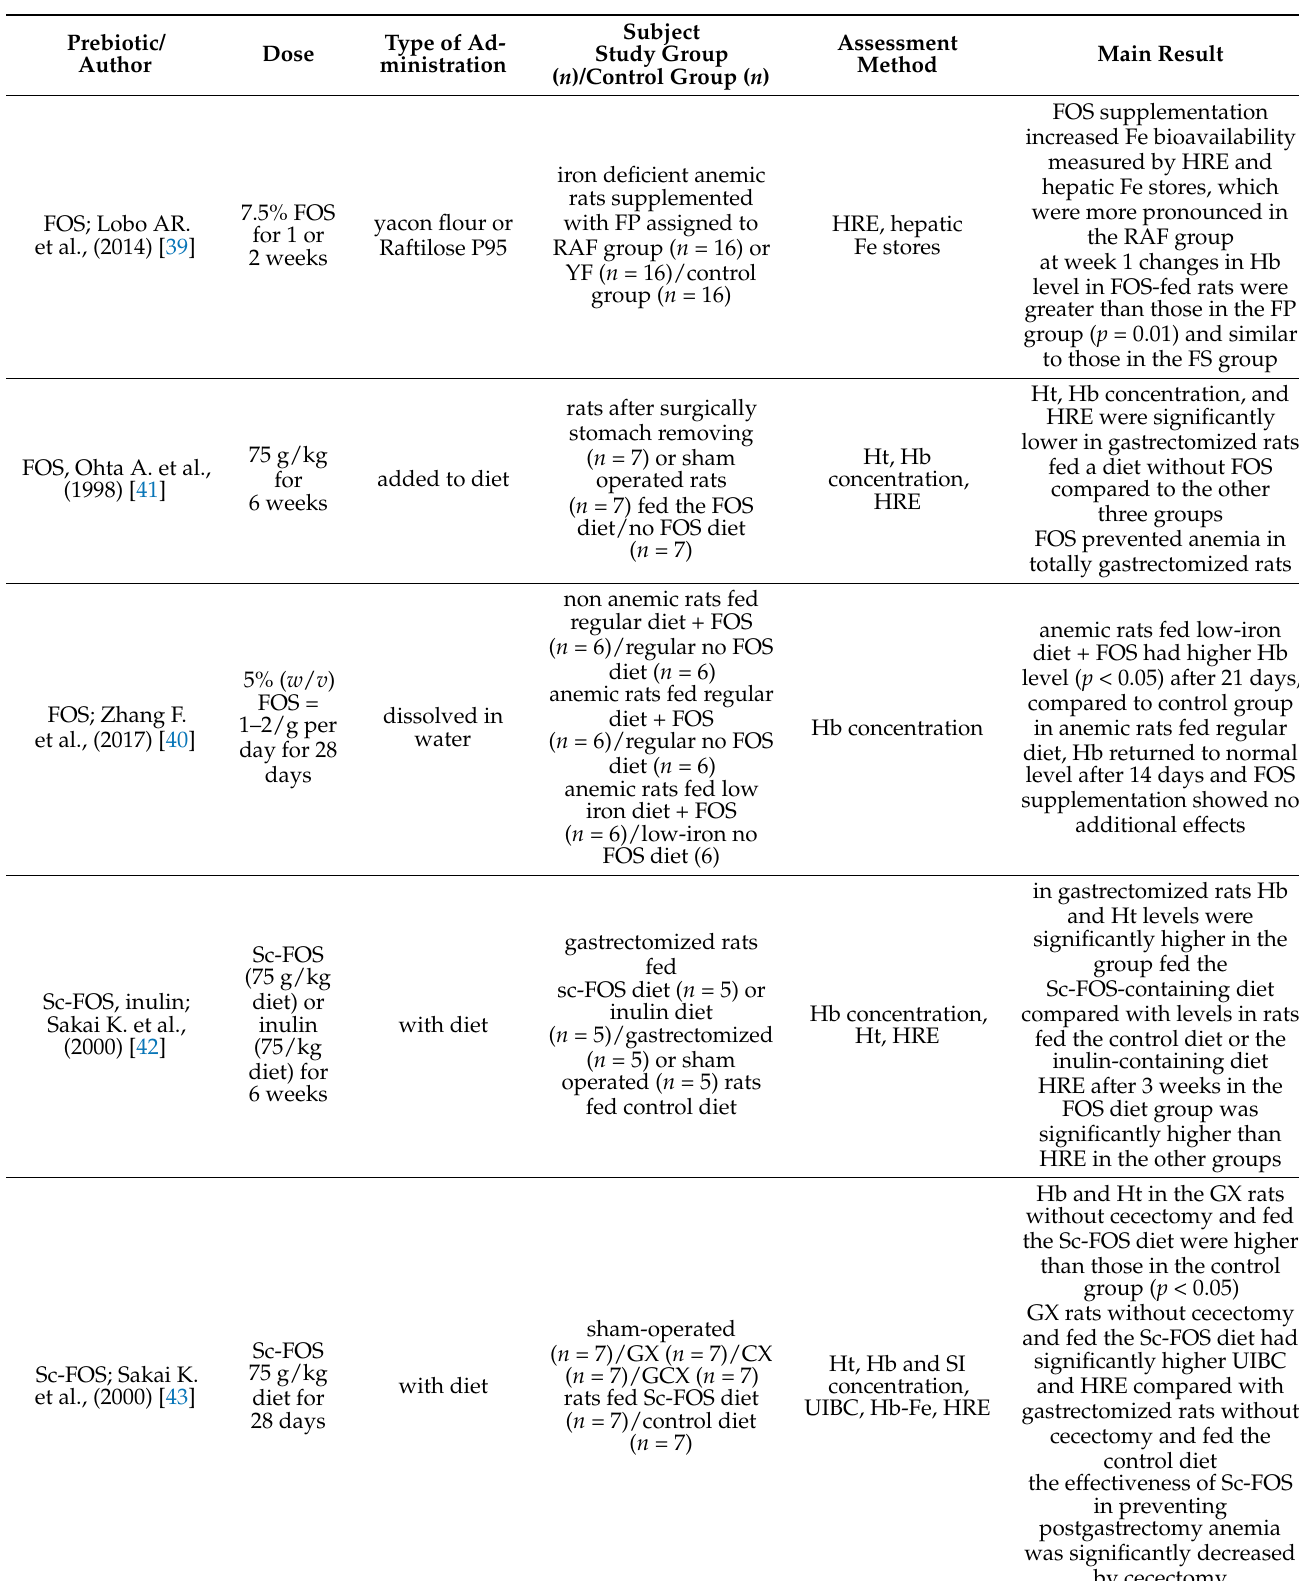
Table 2. Summary of animal studies on prebiotics in